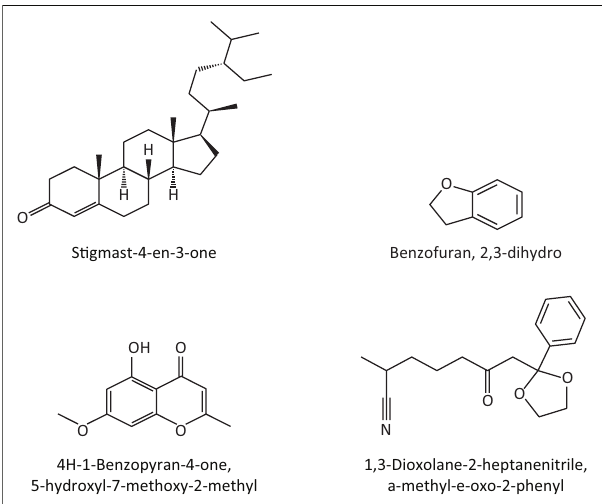
FIGURE 3: Chemical structure of some of the compounds identified by gas chromatography – mass spectrometer.